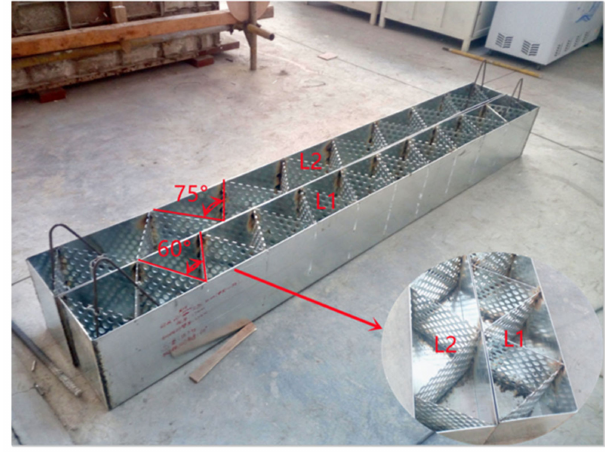
Figure 2. Detailed of multi-cavity steel plate framework and parts. Table 1. Parameter of composite beam